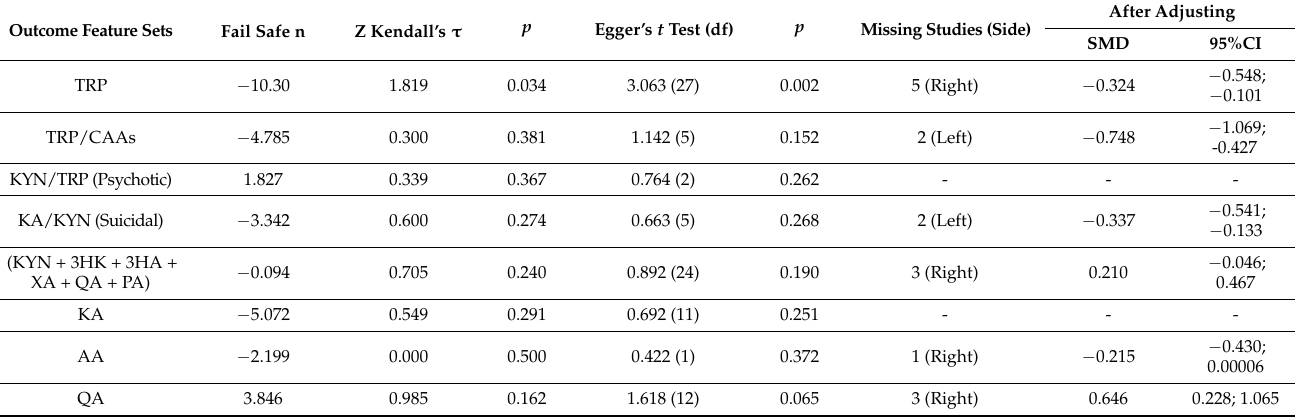
Table 3. Results on publication